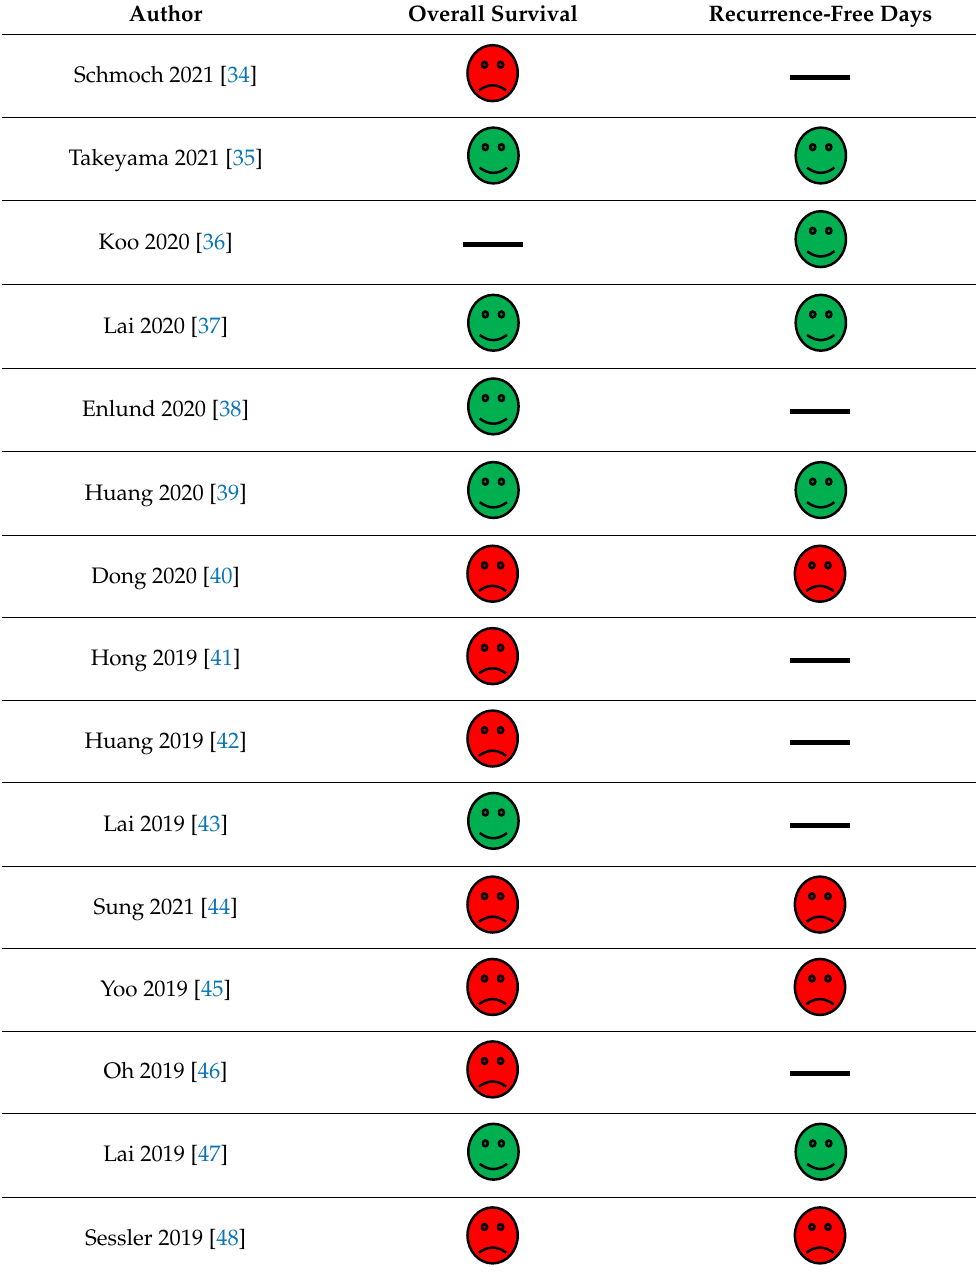
Table 1. Studies investigating the effect of intravenous anesthetics versus inhalation anesthetics on overall survival and cancer-free survival.